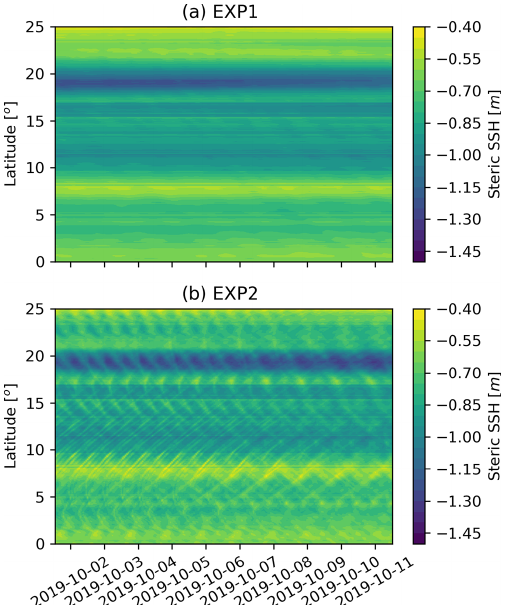
Figure A5. Hovmöller diagram of steric SSH along the section of 135 ◦ E. EXP2 with tide shows obvious signals of the propagation of internal tide. This figure, together with Fig. 14g–h, explains how the internal tide signature affects the simulated